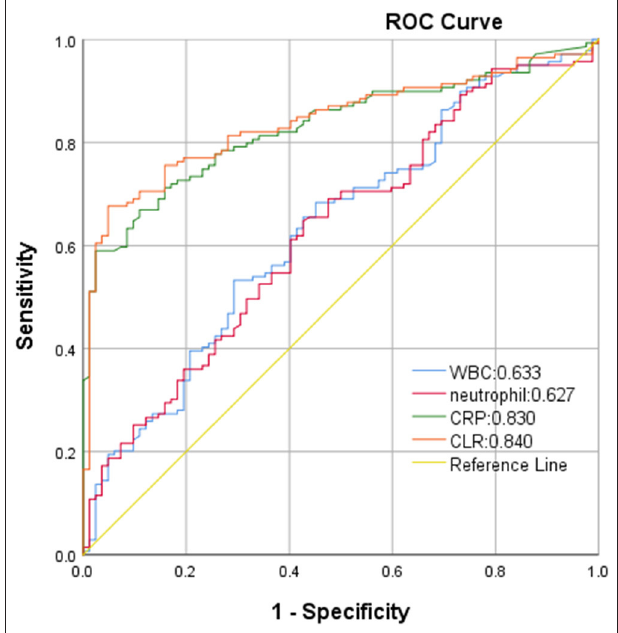
FIGURE 2 | Receiver operating characteristics (ROC) curve of CLR in predicting poor outcome of aSAH patients.